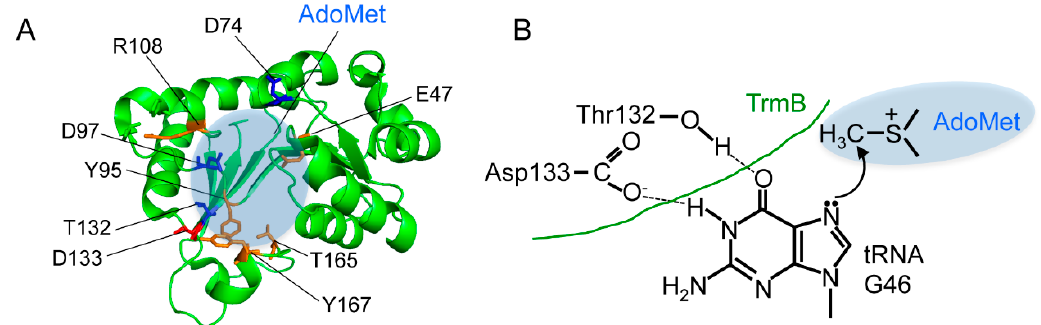
Figure 4. The amino acid residues for AdoMet binding and hypothetical reaction mechanism of TrmB. ( A ) The amino acid residues (E47, Y95, R108, T165 and Y167) involved in AdoMet binding (orange) are indicated on the catalytic domain of B. subtilis TrmB structure (PDB: 2FCA). The hypothetical catalytic center (grey shading), Asp133 (red) and the other important amino acid residues (D74, D97 and T132; blue) are highlighted. ( B ) Hypothetical reaction mechanism of eubacterial TrmB proteins is drawn.